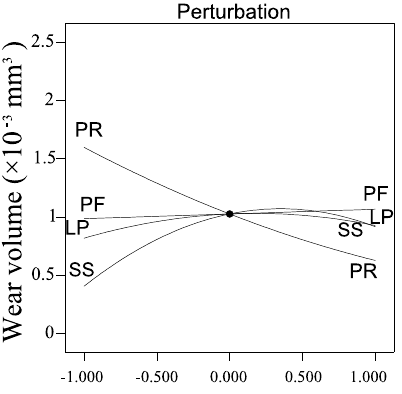
Figure 10. Influence on wear volume by the different LENS process parameters.